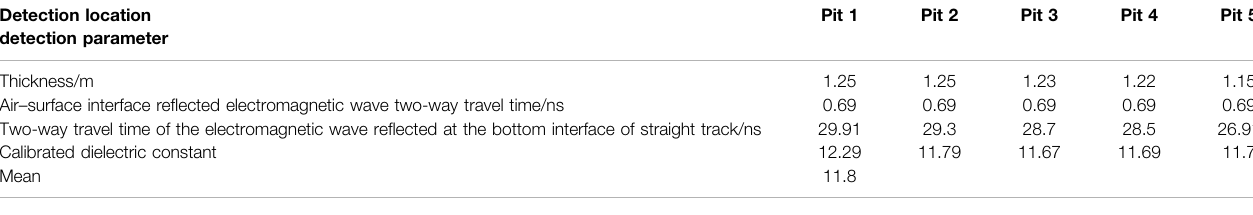
TABLE 1 | Calibrated dielectric constant calculation table. Detection location detection parameter